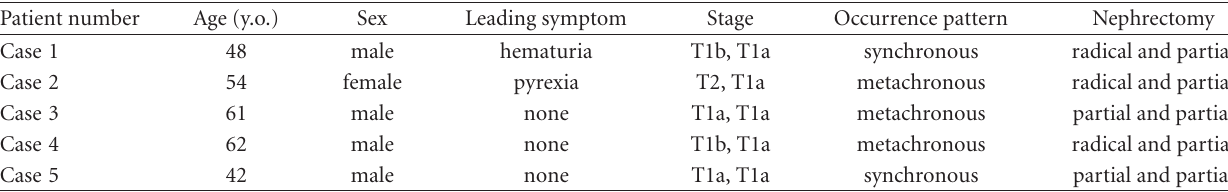
Table 1: Patients, their characteristics at the initial visit, occurrence pattern of renal tumors, and surgical approaches. Patient number Age (y.o.)